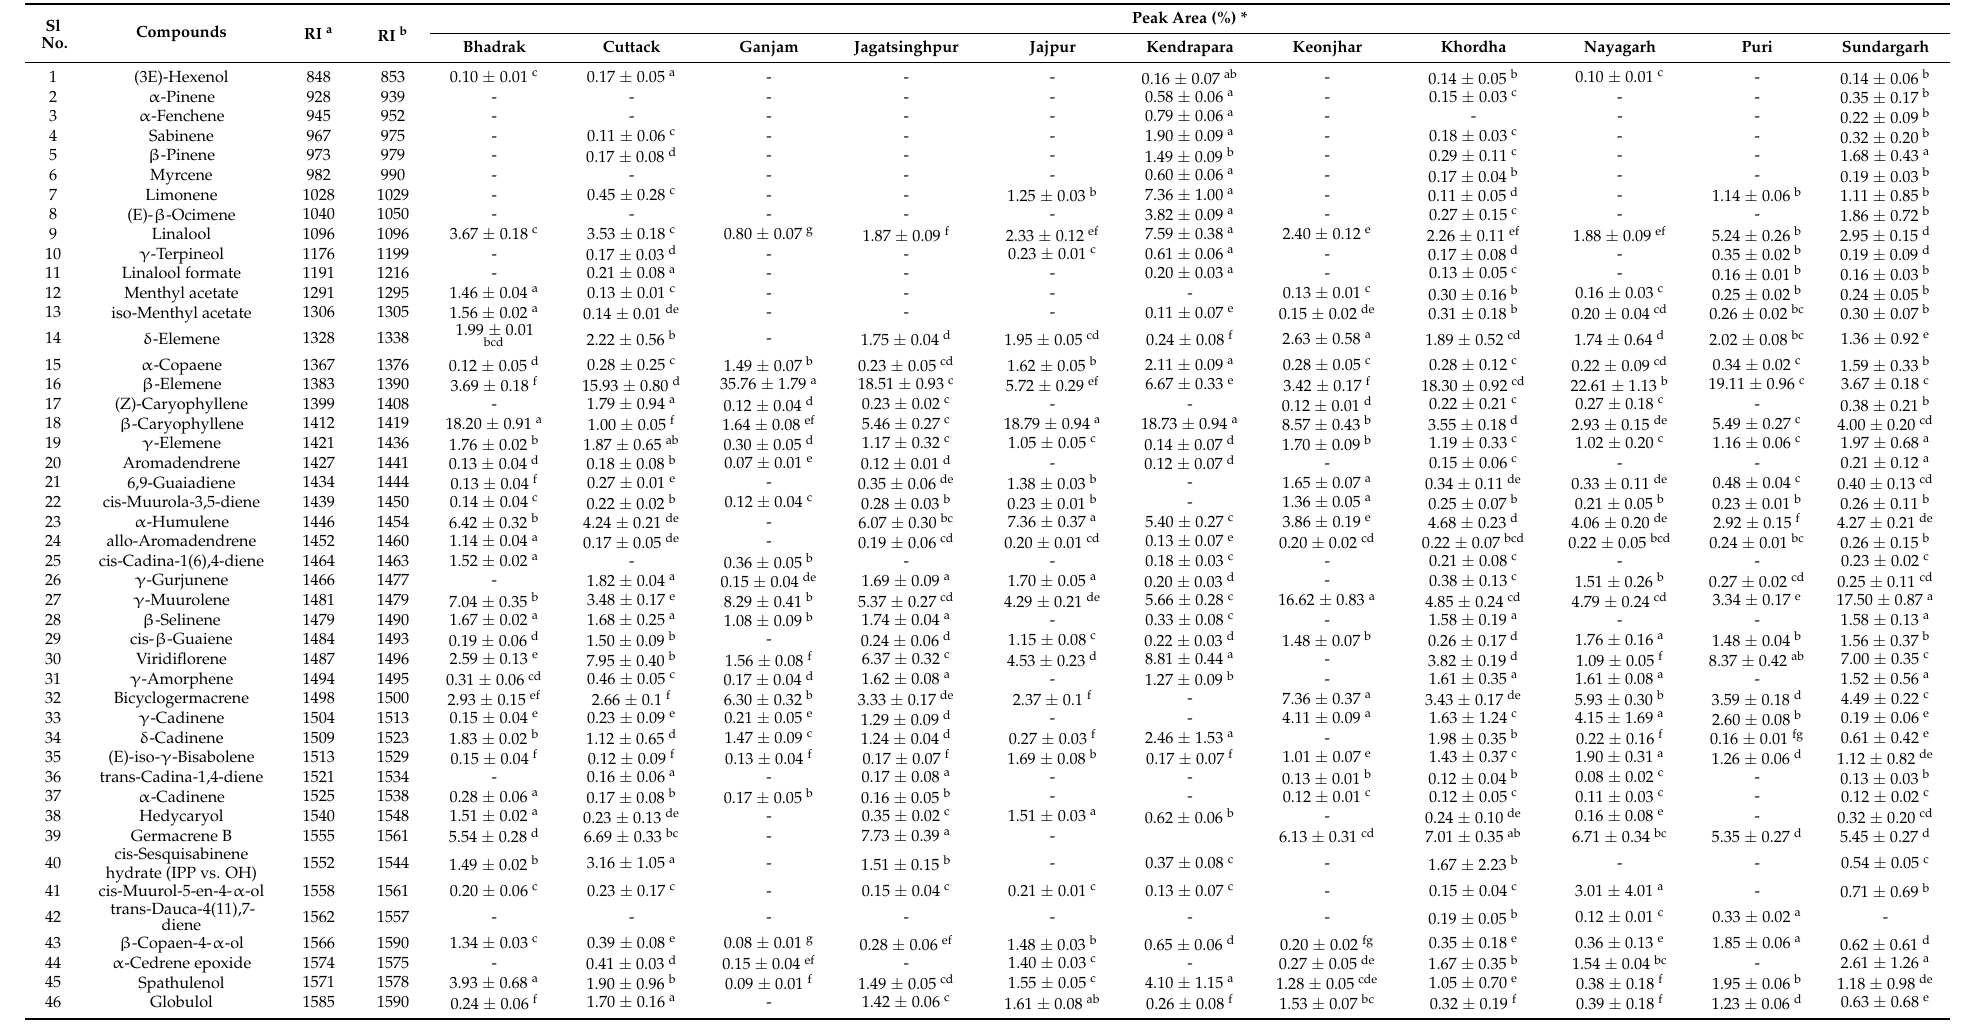
Table 2. Relative contents of each constituent in Magnolia champaca leaf essential oil from Bhadrak (N = 4), Cuttack (N = 3), Ganjam (N = 3), Jajpur (N = 3), Jagatsinghpur (N = 3), Kendrapara (N = 3), Keonjhar (N = 3), Khordha (N = 11), Nayagarh (N = 4), Puri (N = 4), Sundargarh (N =